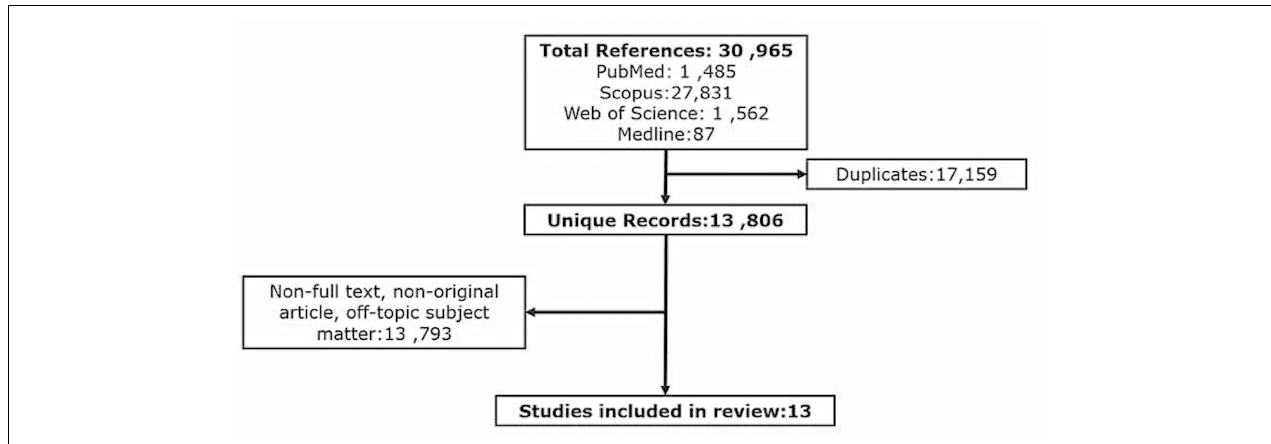
FIGURE 2 | Flow diagram showing the methodical identification and selection of studies investigating the therapeutic potential of EVs to in-vivo models of perinatal brain injury.